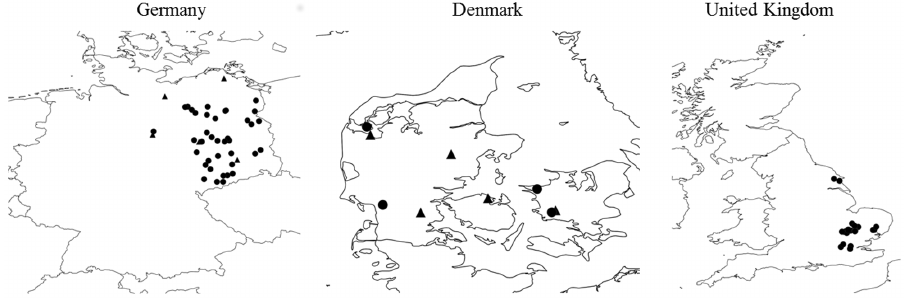
Fig 1. Locations of cabbage stem flea beetle samples. The triangles indicate samples where a full dose- response and kdr frequency was